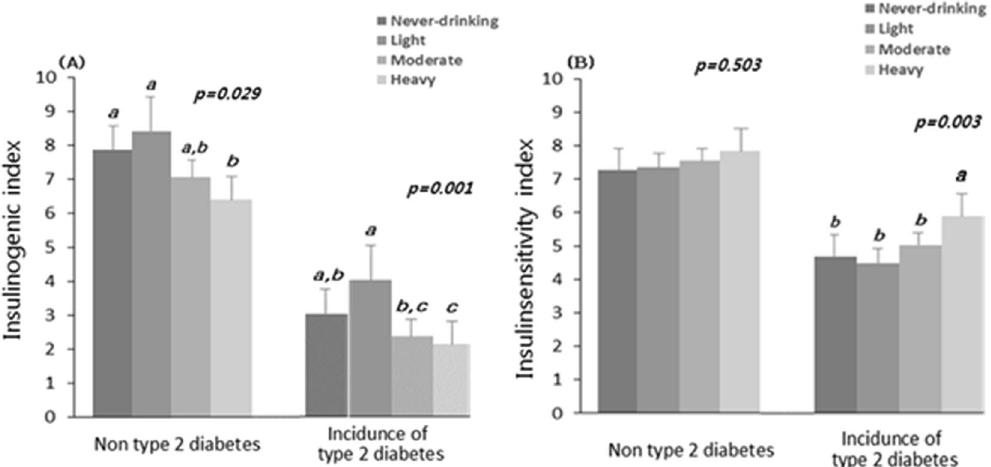
Figure 2. The associations between alcohol consumption pattern and ( A ) insulin secretion capacity (IGI 60) and ( B ) insulin sensitivity (ISI) at the end point of follow-up. A , and B is shown as the geometric mean and Error bars represent 95% CIs. P -values were determined using one-way anova and post-hoc (Duncan) for continuous variables according to alcohol consumption pattern at baseline and over 10-years. Different letters, a,b,c,d, indicate significant difference of means among four groups by Duncan